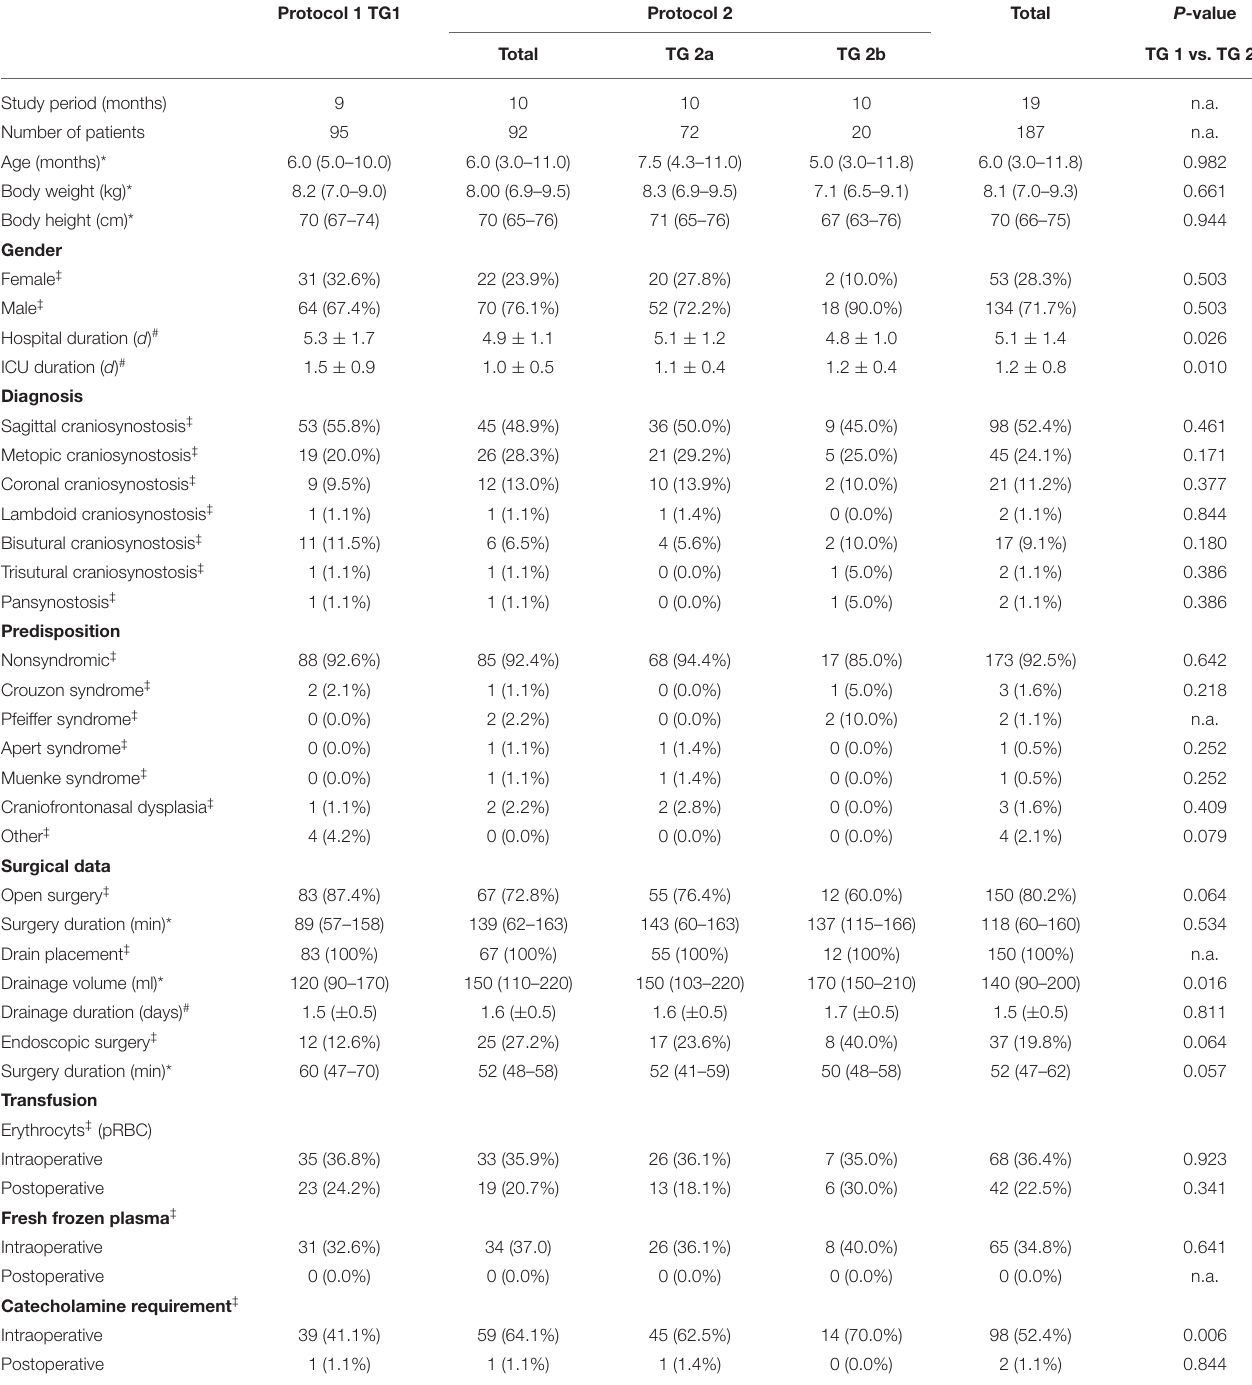
Protocol 1, prolonged perioperative antibiotic treatment; Protocol 2, single-shot antibiotic treatment. TG 2a, treatment according to protocol; TG 2b, deviations from the antibiotic treatment protocol; pRBC, packed red blood cells. * Variables are reported as median with interquartile range. # Variables are reported as mean ± standard deviation. ‡ Variables are reported in the number of patients and percent of patients. n/a, not